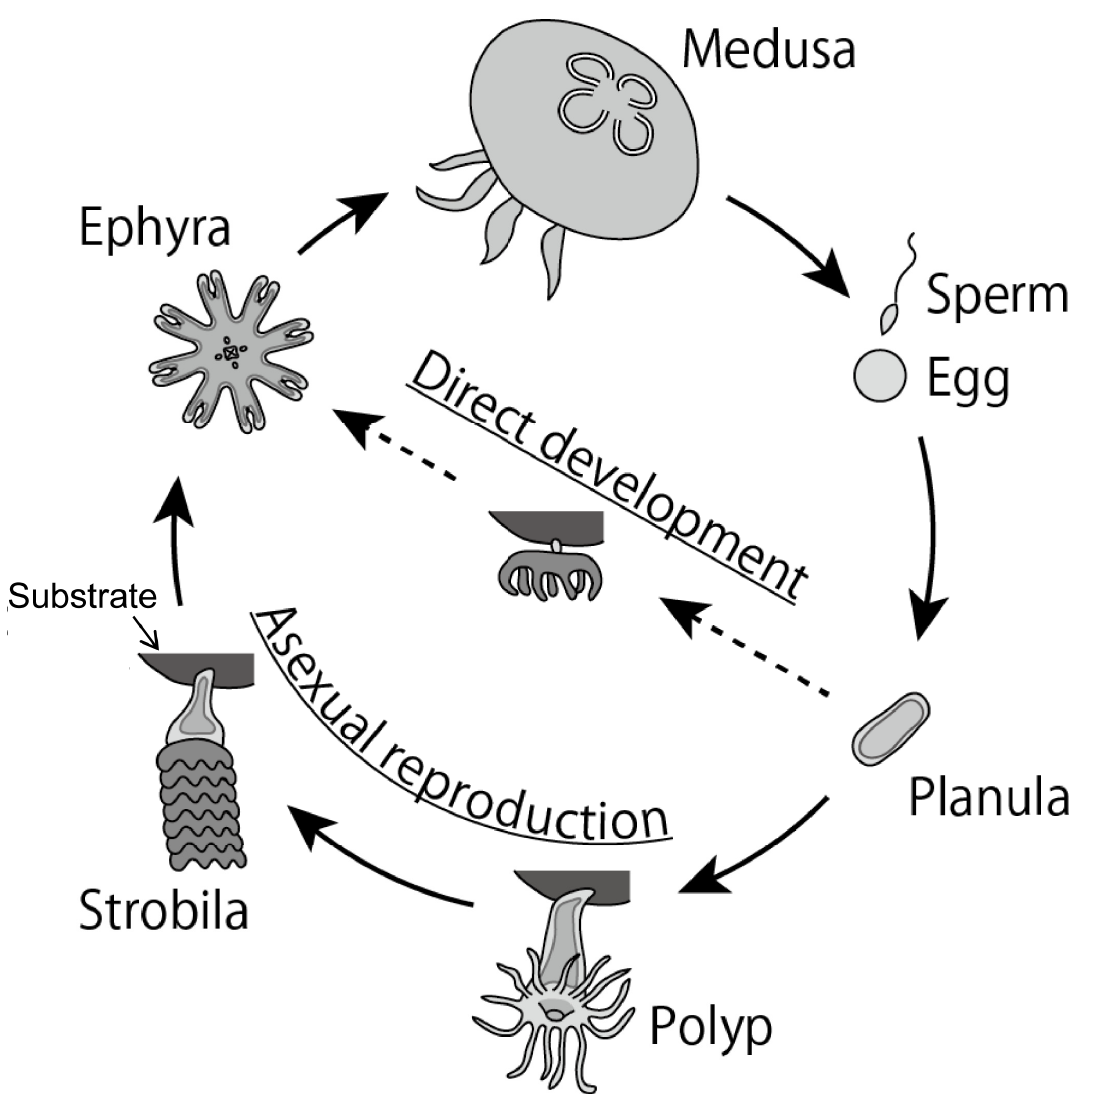
Fig 1. Two life cycle types of Aurelia spp. The life cycles are illustrated based on